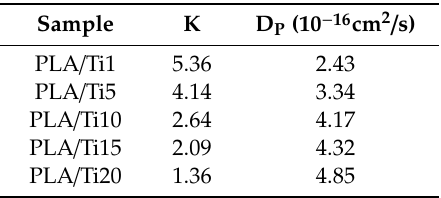
Table 1. The distribution coe ffi cient and di ff usion coe ffi cient of Poly (lactic acid) (PLA) / nano-TiO 2 composite films by high pressure treatment.